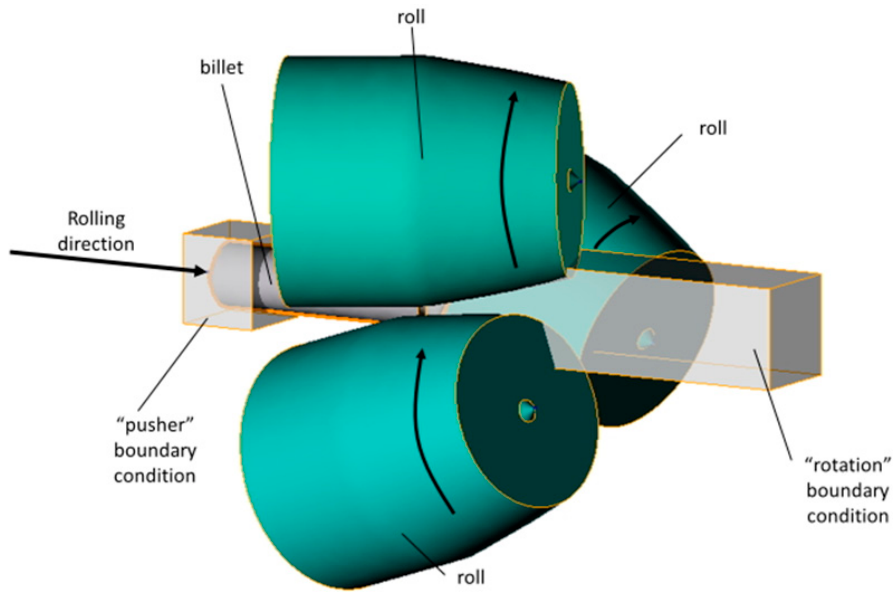
Figure 1. QForm model for computer simulation of three-high radial shear rolling in an MISIS-100T rolling mill (arrows identify rolls’ rotation directions).